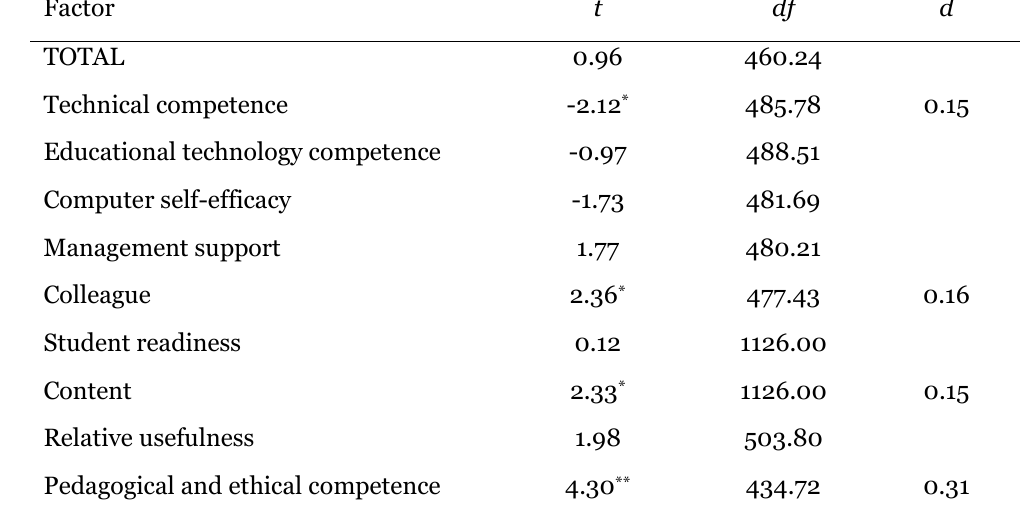
T Tests by Gender Factor